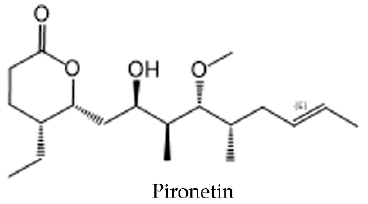
Figure 8. Structure of pironetin.